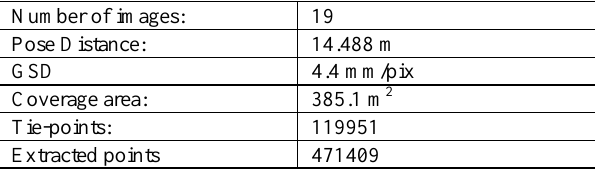
Table 1 - Results of PhotoScan model construction processing